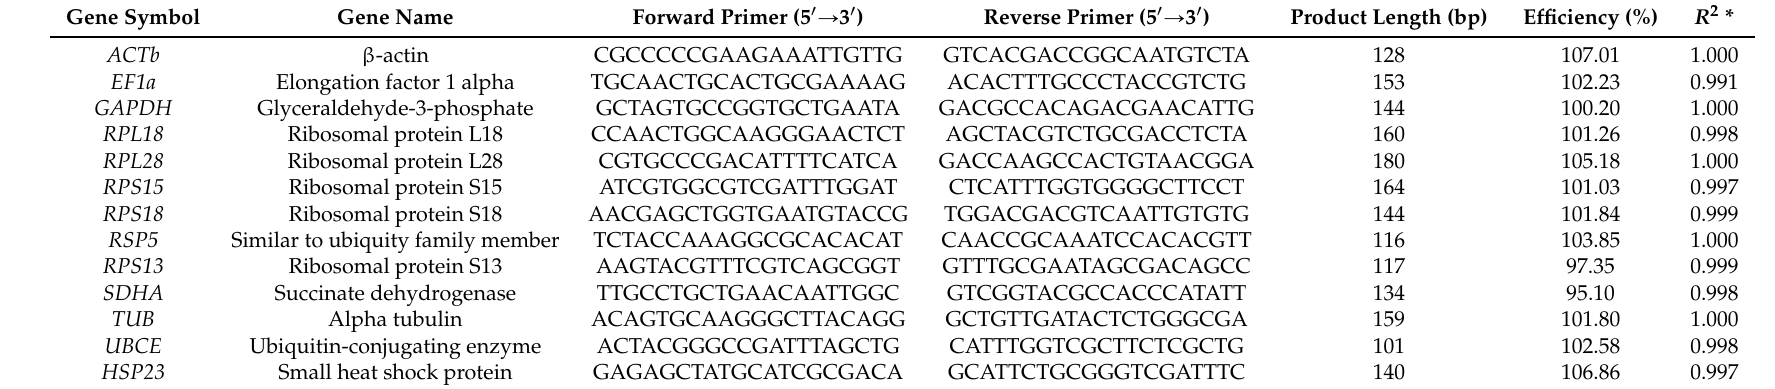
The gene source was transcriptome data in all cases. * Regression coefficient obtained according to standard regression